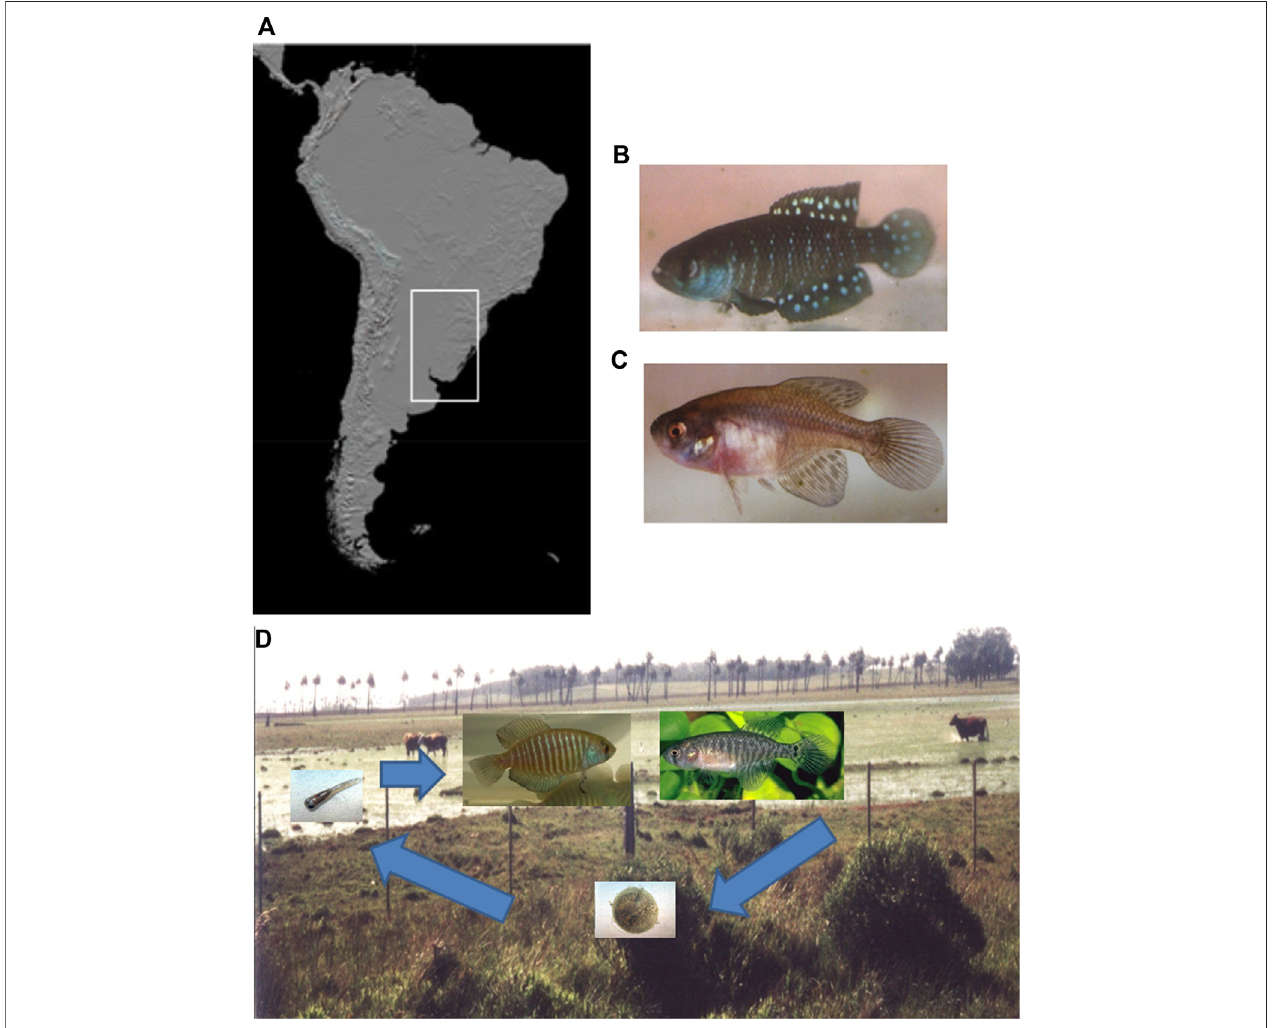
FIGURE 1 | Continental occurrence area, specimens, and life cycle of annual fi sh Austrolebias. (A) Distribution area of the Austrolebias genus in South America (white rectangle). (B) Adult male of the A. af fi nis species group. (C) Adult female of the A. af fi nis species group. (D) Life cycle of annual fi sh Austrolebias in temporary ponds from the R.16, Rocha Department, in Uruguay. A. charrua male (left) and female (right) are shown, the embryos remain in a prehatching stage of developmental arrest and hatch in the next rainy season when the ponds are fl ooded. The resulting juveniles reach sexual maturity in a few weeks.